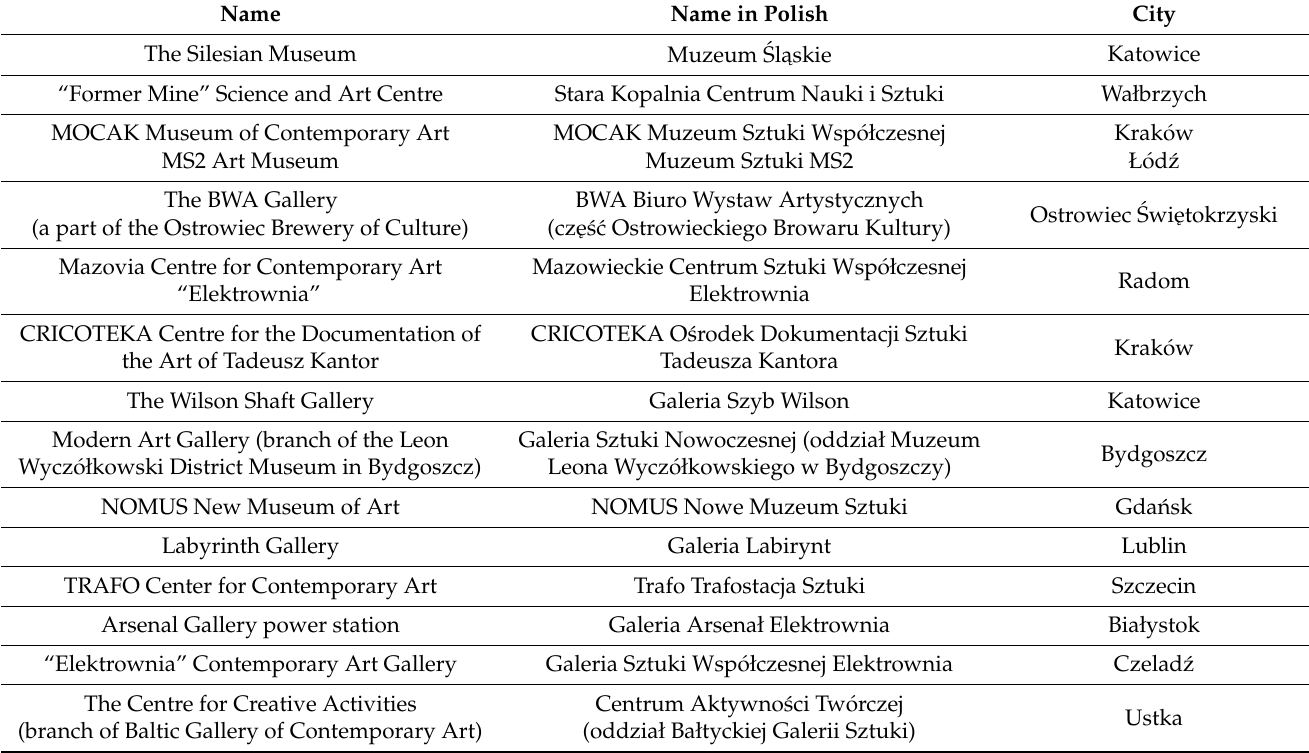
Table 1. List of post-industrial objects adapted to an art exhibition function in Poland. Name Name in